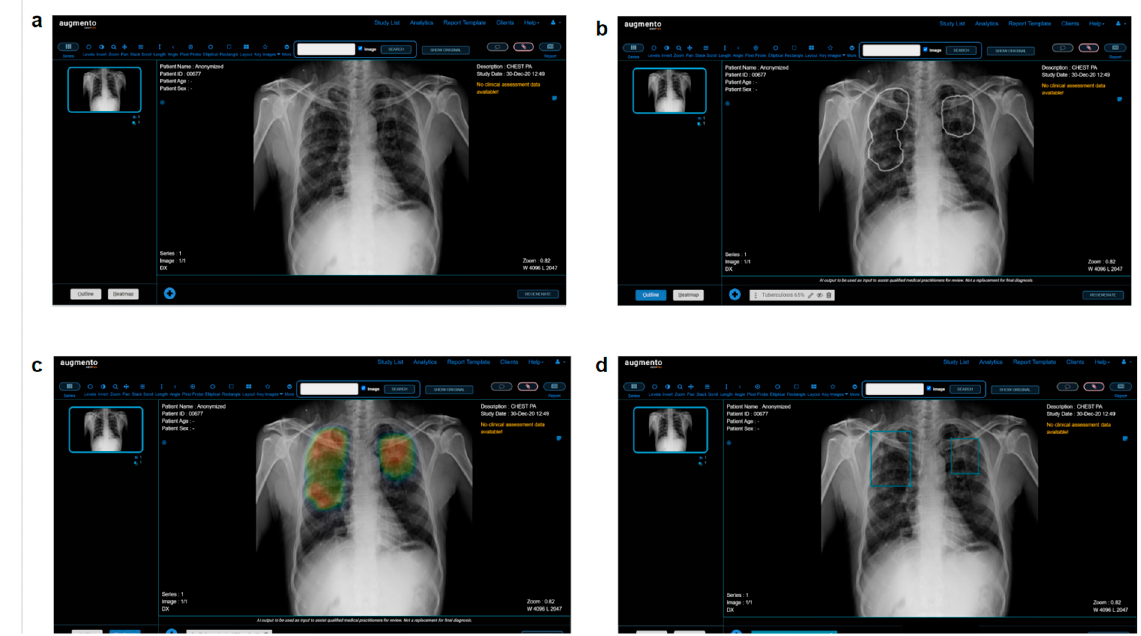
Figure 2. ( a ) Screenshot of Augmento, as seen by human readers. The readers can check the AI predictions in the ( b ) outline or ( c ) heatmap view and annotate the scans using ( d ) bounding boxes. Once the annotations are complete, a radiology report is generated.